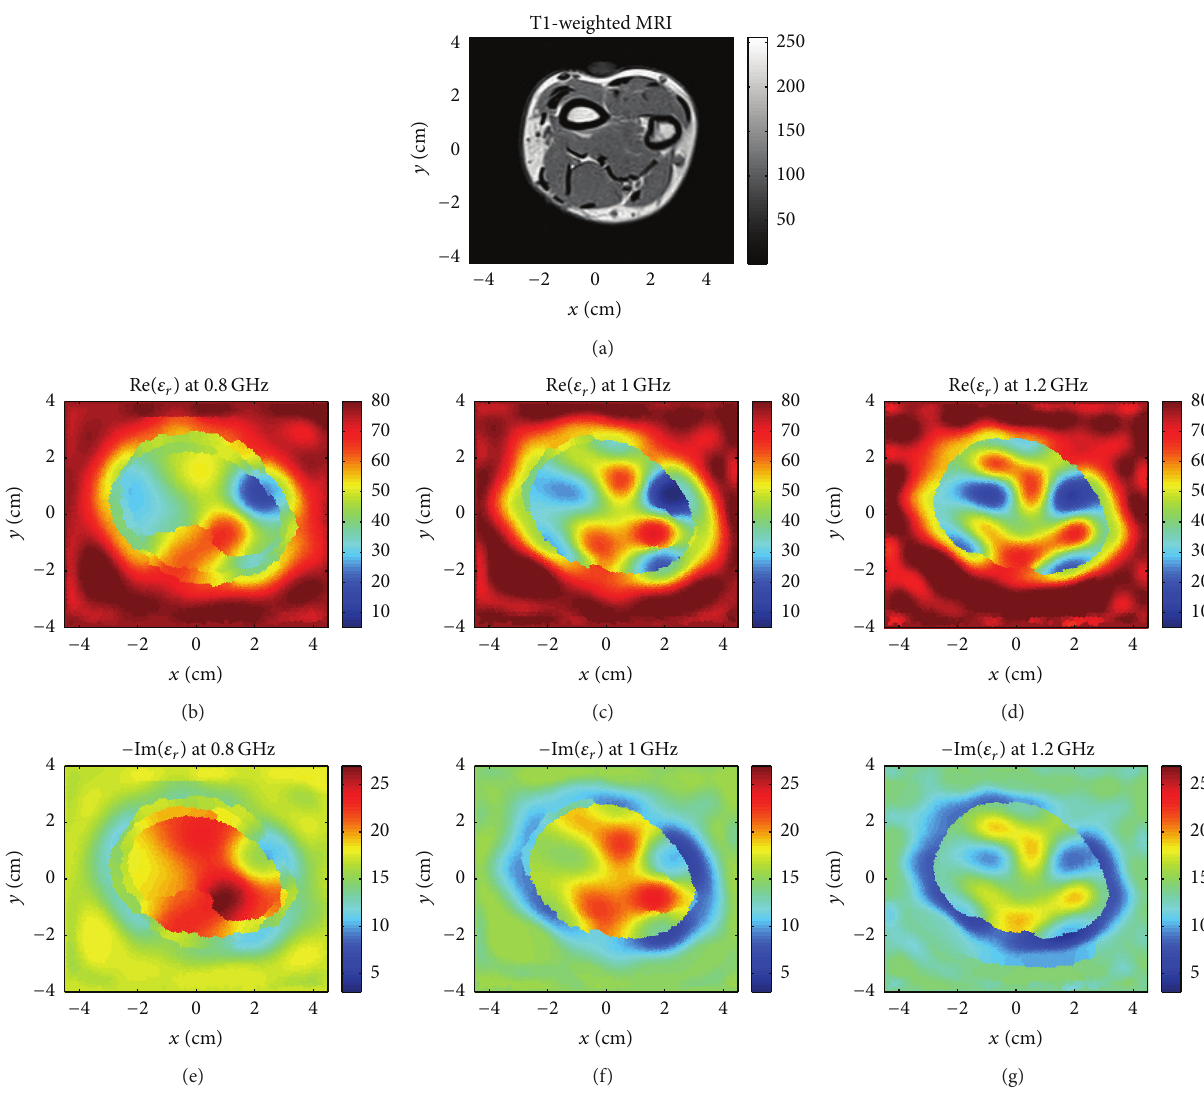
Figure 7: Volunteer 4: (a) the T1-weighted MRI image. MWI reconstructions of the relative complex permittivity real and imaginary compo- nents at (b), (e) 0.8 GHz, (c), (f) 1GHz, and (d), (g)